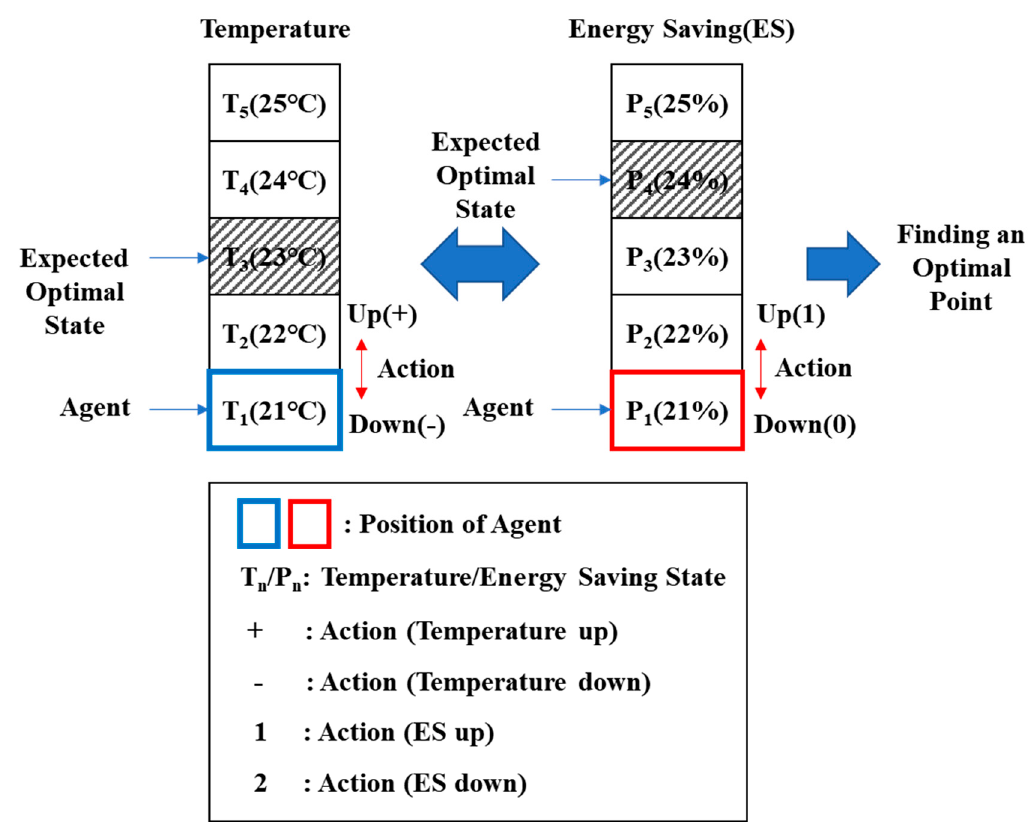
Figure 13. The method of finding an optimal point.